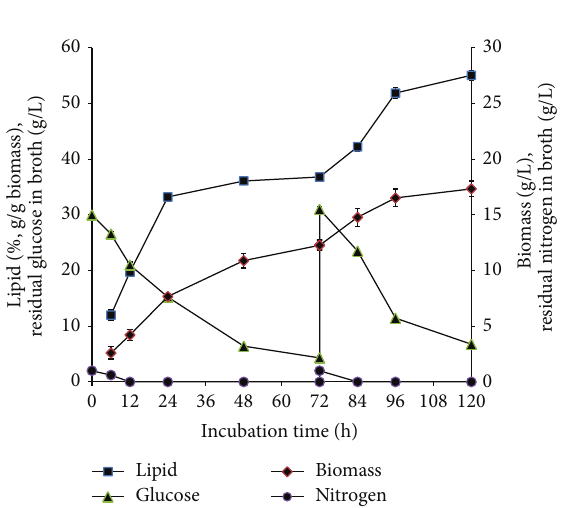
Figure 5: Effect of feeding ammonium tartrate, glucose, and Fe 3+ at 72 h in lipid accumulation of C. bainieri 2A1. The culture was cultivated in 500 mL shake flask containing 200 mL of nitrogen- limited medium at 30 ∘ C, 200 rpm, and starting inoculums of 10% (v/v). The data represent means ± SDs, 𝑛 = 3 .